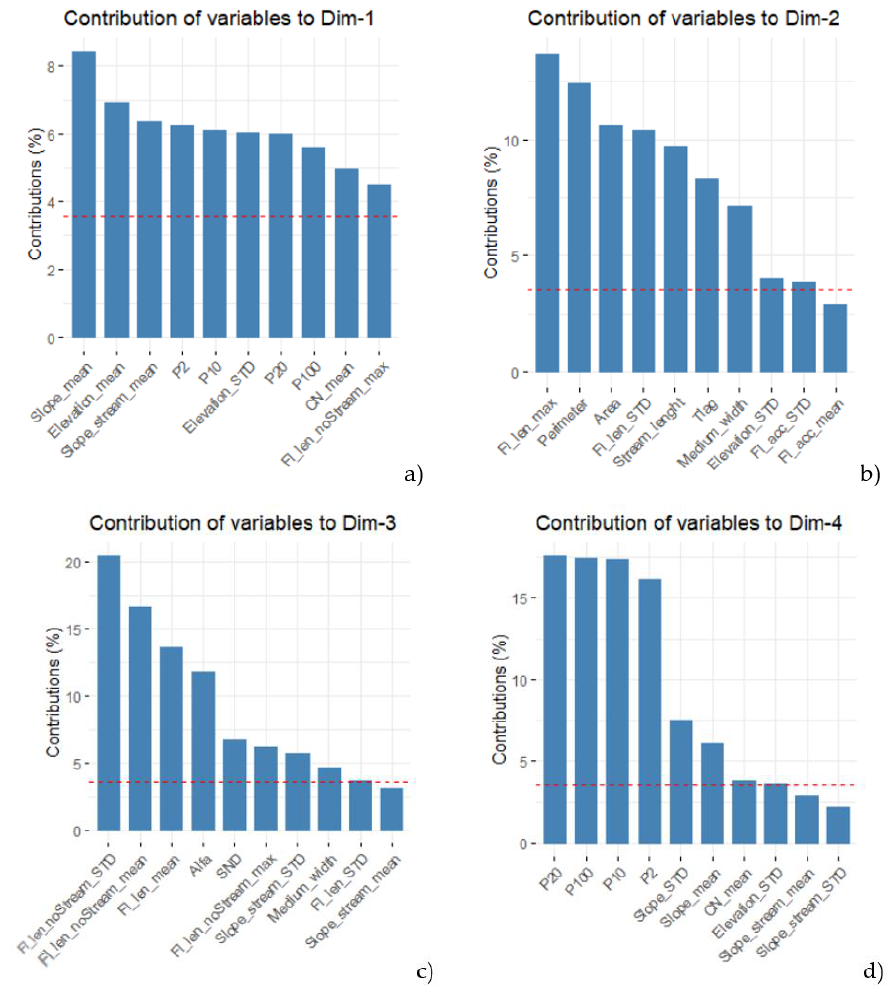
Figure 4. Contribution of variables for first four dimensions of PCA for all parameters. ( a ) to first, ( b ) second, ( c ) third, ( d ) fourth substitute variables.